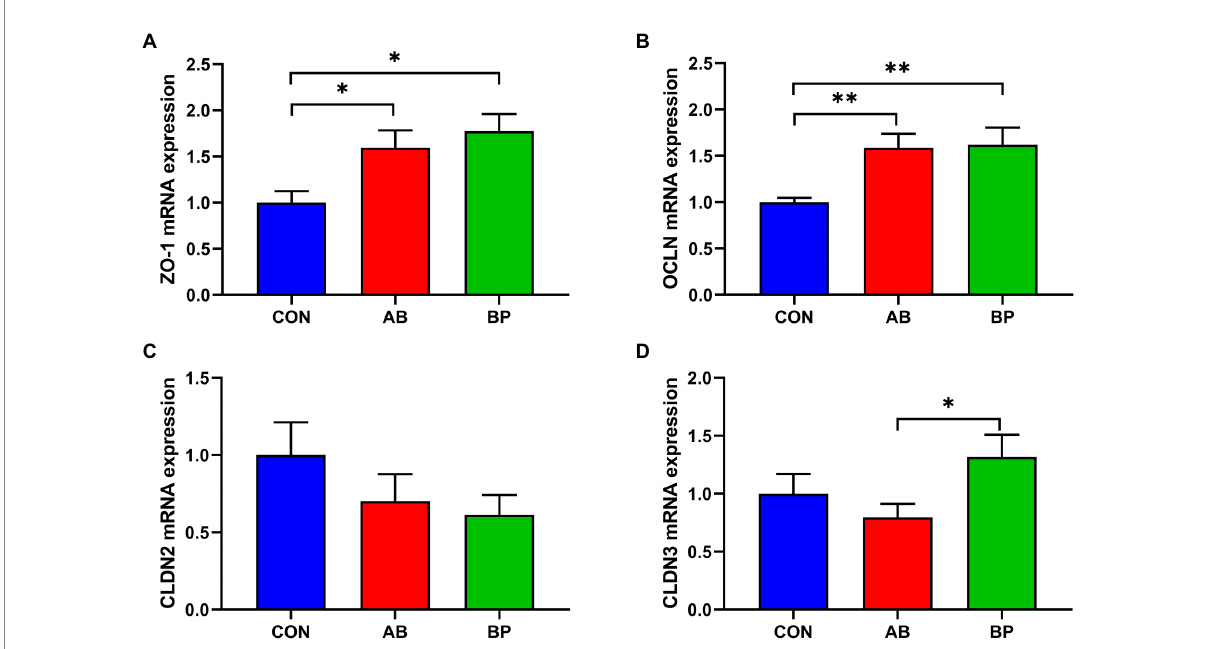
FIGURE 6 Effects of dietary supplemented with Bopu powder on expressions of barrier genes in intestine of broiler chickens. (A) zonula occludens-1 ( ZO-1 ); (B) occludin ( OCLN ); (C) claudin-2 ( CLDN2 ); and (D) claudin-3 ( CLDN3 ). CON group, broiler chickens fed a basal diet; AB group, broiler chickens fed a basal diet supplemented with 50 mg/kg aureomycin; BP group, broiler chickens fed a basal diet supplemented with 40 mg/kg Bopu powder containing protopine and allocryptopine. Values are mean ± standard error ( n = 6). * p < 0.05, ** p <